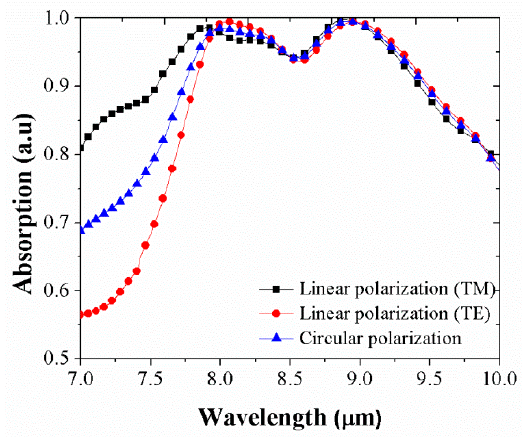
Figure 7. Comparison of TM mode, circular polarization and TE mode for simulated absorption curves from devices of integrated ENZ perfect absorber at Brewster angle.